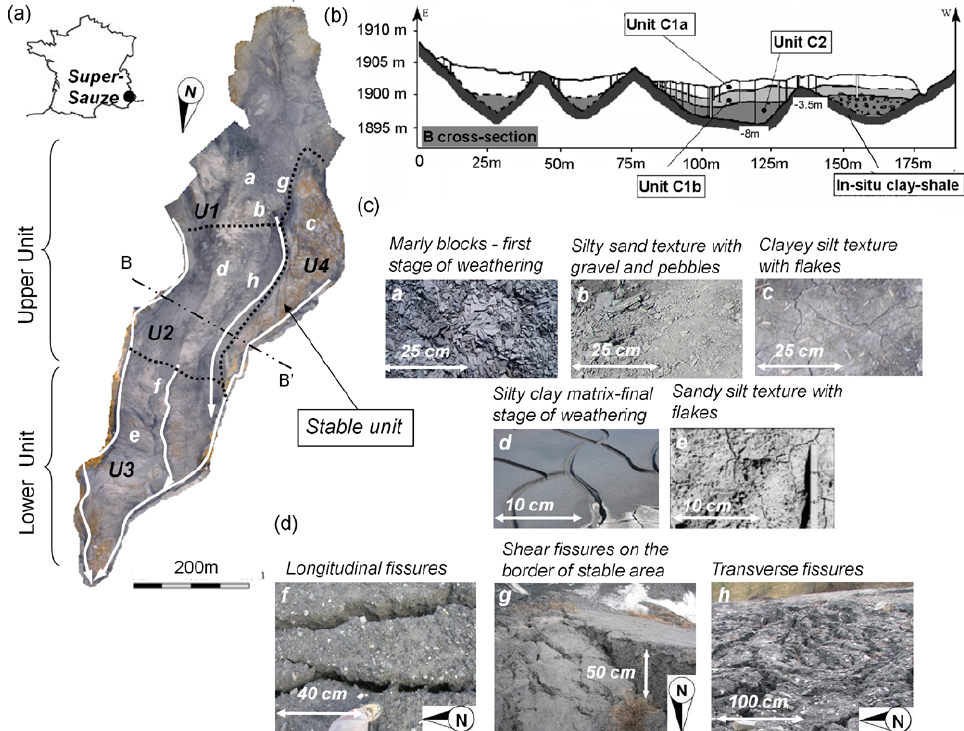
Fig. 2. (a) The Super-Sauze landslide with indicated hydro-geomorphological units (after Malet et al., 2005), the main streams/drainage paths within landslide (white arrows) and location of B-B 0 cross section; (b) geotechnical structure observed in B-B 0 ; (c) soil surface characteristics observed over the landslide area; (d) example of fissures formations observed over the landslide area. Pictures taken during filed campaigns in May and July